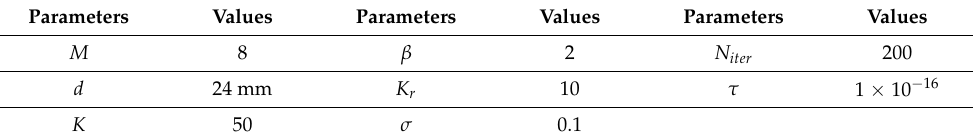
Table 4. Simulated parameters.